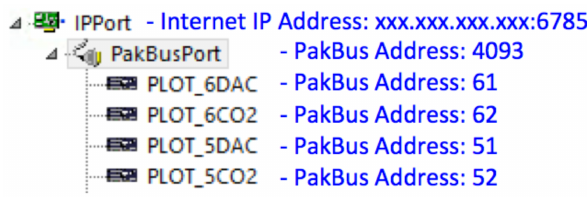
Figure 4. Example PakBus addresses assigned at